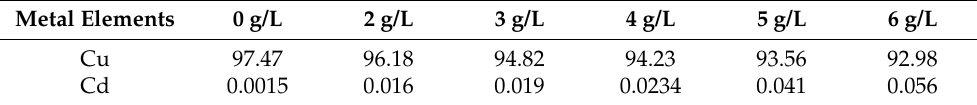
Table 3. Copper purity of cathode with different Cd 2+ concentrations in the third stage. Metal